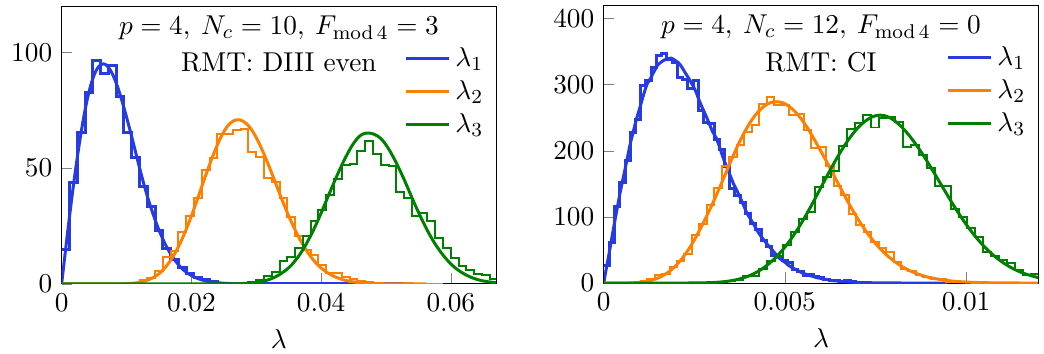
Figure 8 . Distributions of the smallest three eigenvalues of M in (5.1) with p = 4 and J = 1 for two sets of N c and F (mod 4). Comparison is made with the predictions (solid lines) of the RMT classes in table 7. The number of independent random samples is 10 4 for each plot. The small deviations from RMT are again e(cid:11)ects of (cid:12)nite N c